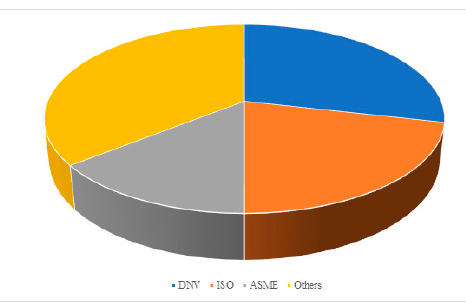
Figure 3. Distribution of research performed on different fields based on transportation.